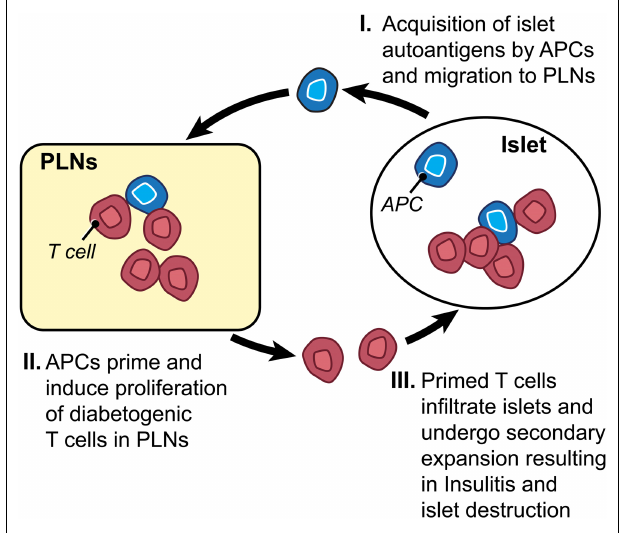
FIGURE 1 | Key events inT1D development. (I)The process starts by acquisition and delivery of islet autoantigens including insulin and GAD65 proteins by antigen presenting cells (APCs) to the draining, pancreatic lymph nodes (PLNs). (II) DiabetogenicT cells encounter their cognate autoantigens presented by APCs in PLNs leading to their priming, proliferation and differentiation into effectorT cells, and homing functions as a result of interaction with APCs. (III) Diabetogenic effectorT cells migrate into the pancreas and infiltrate pancreatic islets causing insulitis and eventually destruction of insulin-producing β